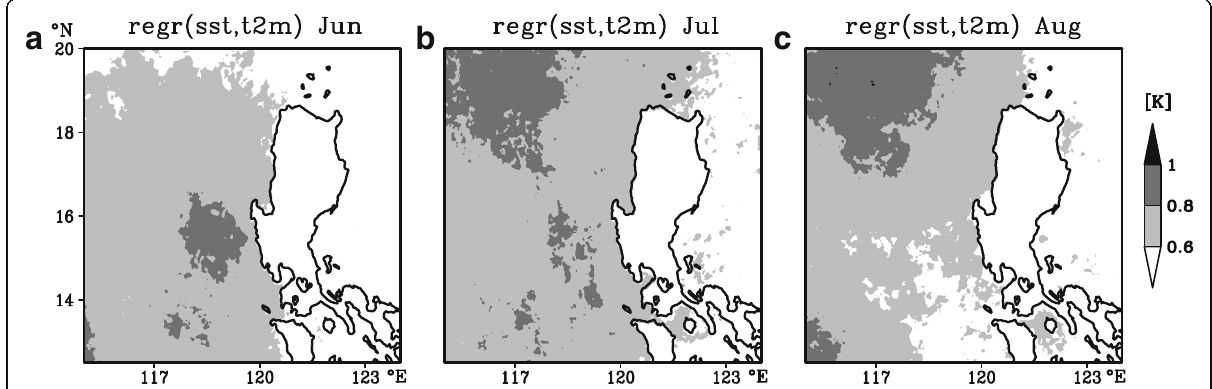
Fig. 10 Spatial map of the regression coefficients of the sensitivity of 2 m temperature (t2m) to the monthly SST anomaly of the WSST reference region for 1982 – 2012 for the months of a June, b July, and c August. The unit is Kelvin (K)